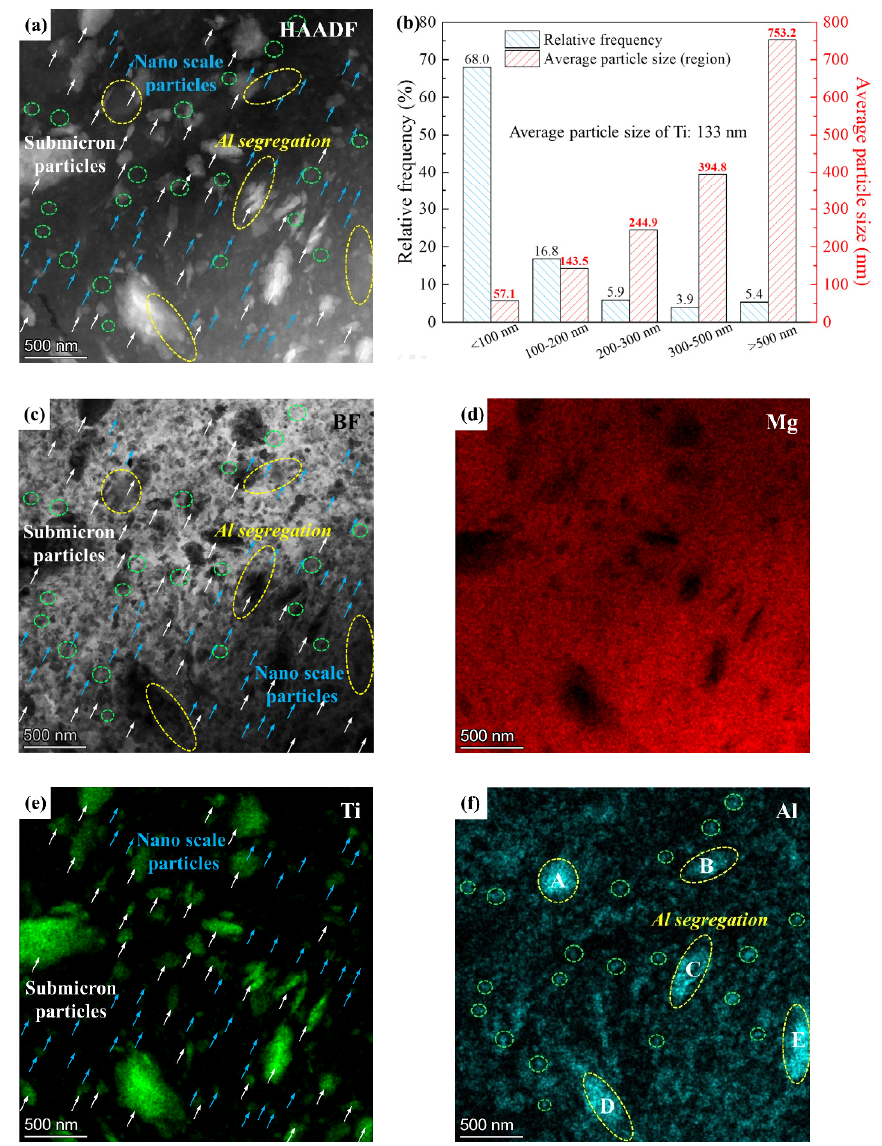
Figure 7. Microstructure of the milled Ti/Mg-9Al-Zn-0.3Mn composite: ( a ) HAADF image, ( b ) particle size statistics of ( a , c ) BF image, ( d – f ) element distribution results.